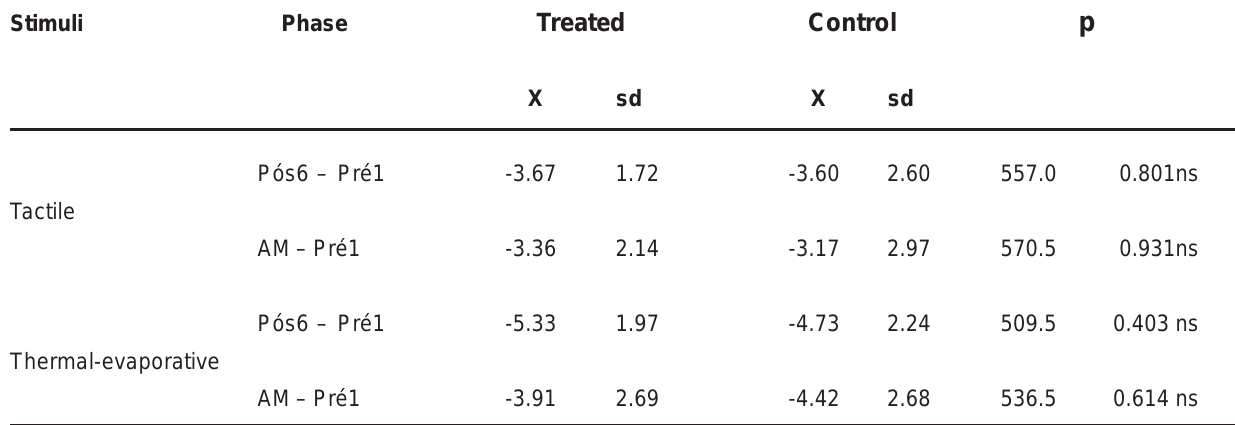
TABLE 2- Representation of the comparative results between Treated and Control groups concerning painful sensation